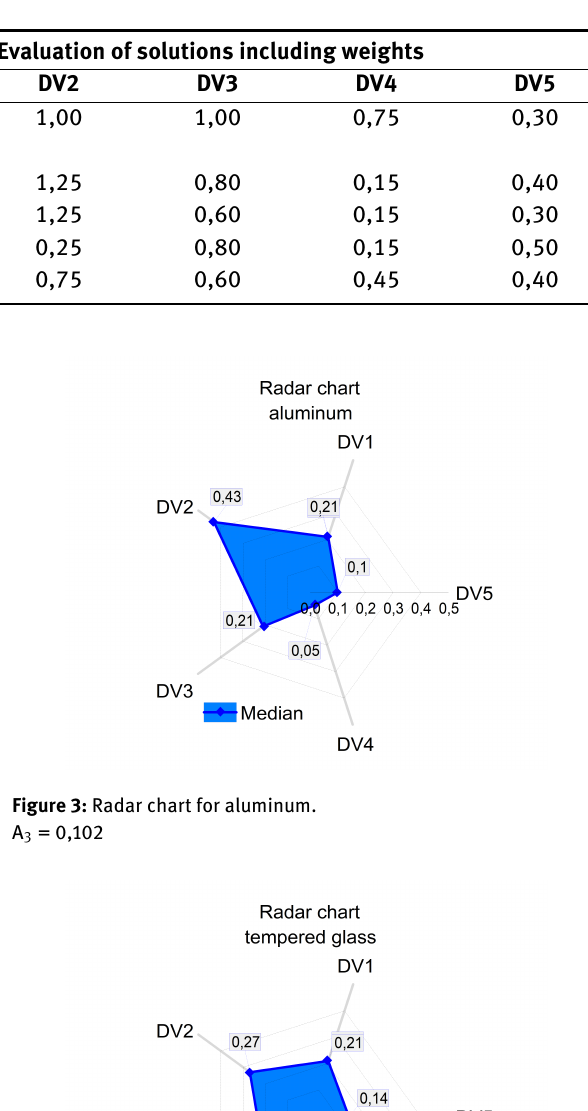
Table 3: Evaluation of solutions including weights.